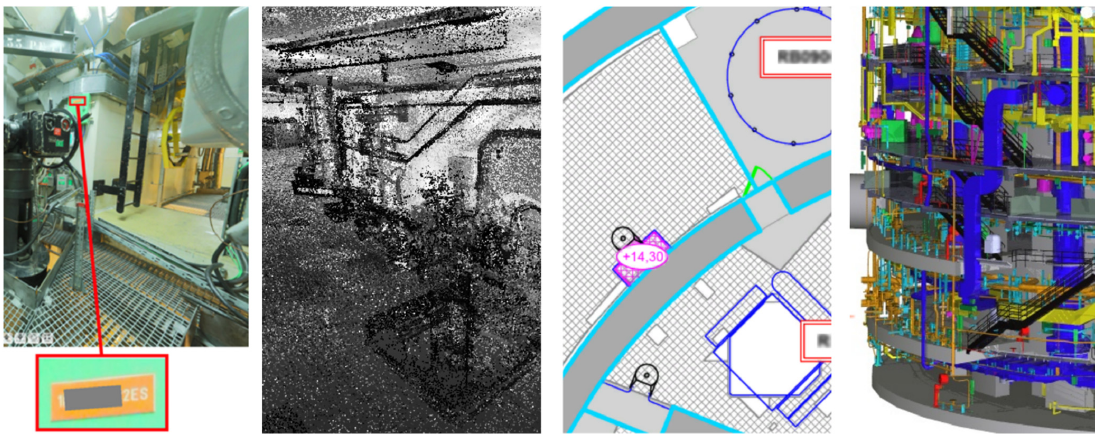
Figure 4. Four types of data are required to represent a power plant facility with a high degree of confidence (geometry and appearance): panoramic images, laser scans, floor maps and 3D CAD model.